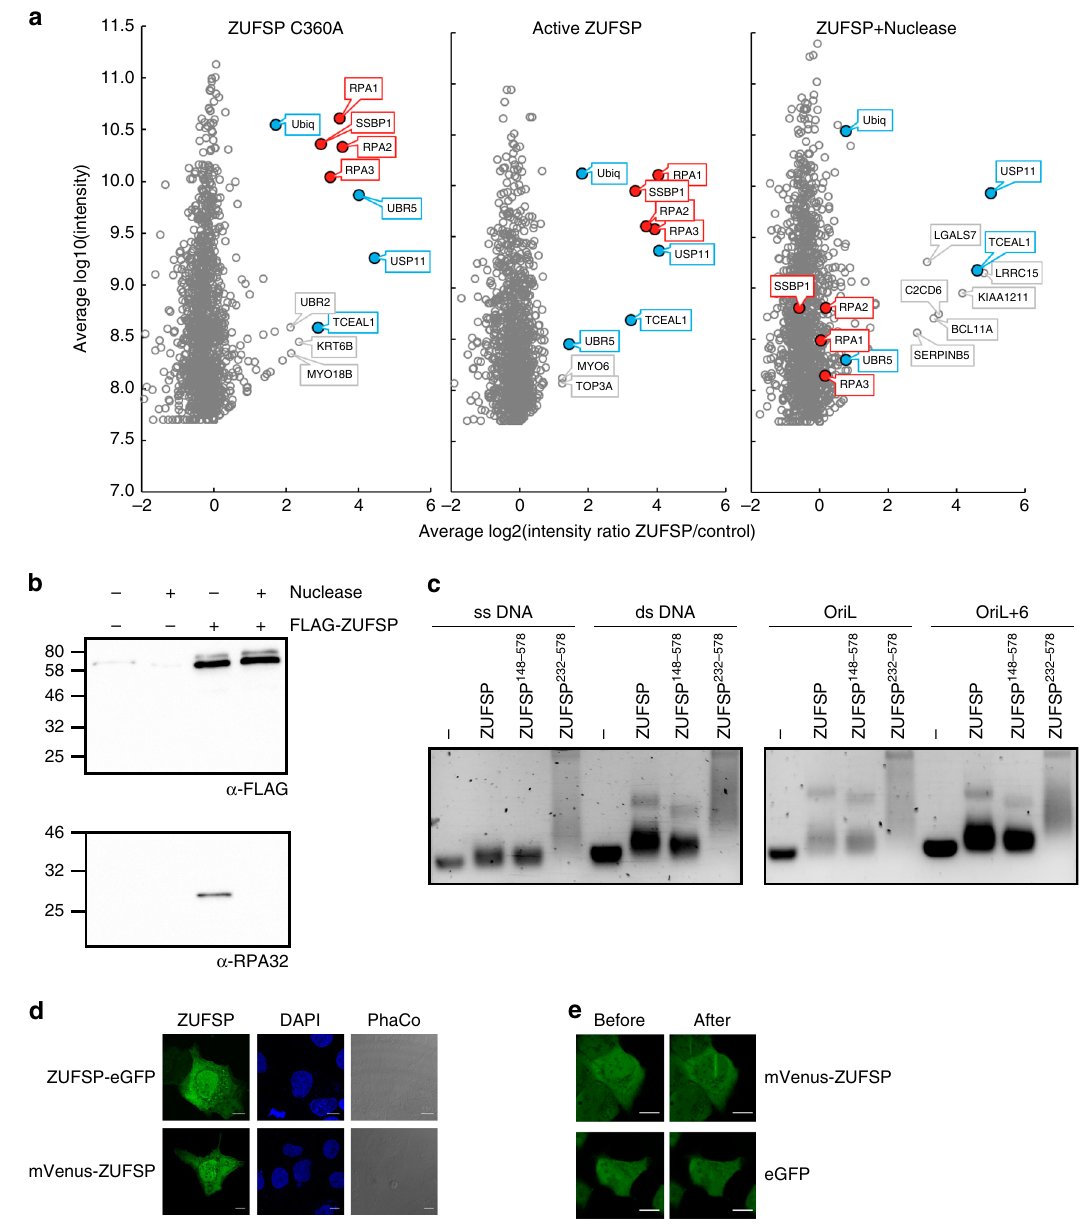
Fig. 6 ZUFSP localization and interaction network. a FLAG-tagged versions of inactive ZUFSP C360A (left) and active ZUFSP (middle, right) were expressed in HEK293T cells and co-precipitating proteins quanti fi ed by mass spectrometry. Log2 enrichment ratios relative to uninduced/untransfected controls are plotted against log10 signal intensity. The right panel shows the results after nuclease treatment. Consistently enriched proteins are labeled in color, red for DNA-dependent and blue for DNA-independent enrichment. The bait ZUFSP is off-scale and hence not shown; the x / y coordinates are 9.7/11.1 (left), 11.0/ 11.2 (middle), and 10.5/11.6 (right panel). b FLAG-tagged ZUFSP was immunoprecipitated from HEK293T cells in the presence or absence of nuclease. Coimmunoprecipitated endogenous RPA32 was visualized with α -RPA32 4E4. c Electrophoretic mobility shift assay (EMSA) comparing the DNA-binding preferences of the full-length ZUFSP to the N-terminal truncations (ZUFSP 148 – 578 and ZUFSP 232 – 578 ). All constructs were tested against a panel of oligonucleotides previously tested for SSBP1 binding 28 , including ssDNA, dsDNA, short hairpin (OriL), and long hairpin (OriL + 6). d Localization of ZUFSP N-terminally fused to mVenus or C-terminal fused to eGFP (green) was visualized in fi xed U2OS cells. Cells are shown in phase contrast (PhaCo) and nuclei are stained with DAPI (blue). Scale bar = 10 µ m. e Localization of mVenus-tagged ZUFSP to sites of NIR laser-induced DNA damage in U2OS cells (top panels), as compared to eGFP alone (bottom panels). Images were taken immediately before (left) and 10 s after 800nm laser irradiation (right). Scale bar = 10 µ